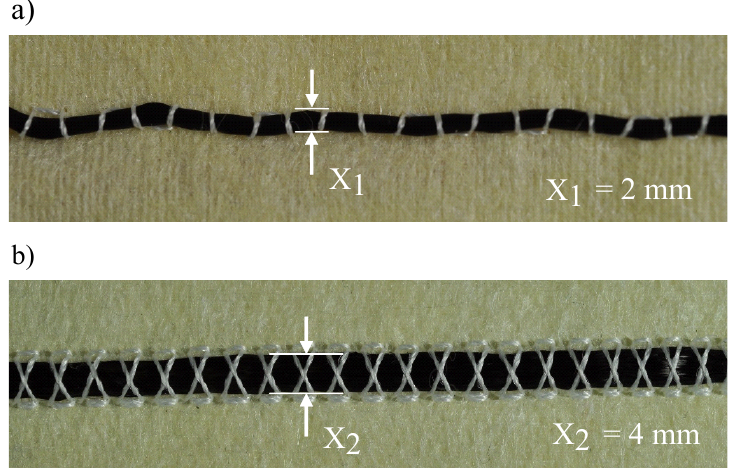
Figure 8. ( a ) Reduced lay-down width of a 12k-HE due to thread-constriction; and ( b ) increased lay-down width of a 12k-HE due to stitch pattern